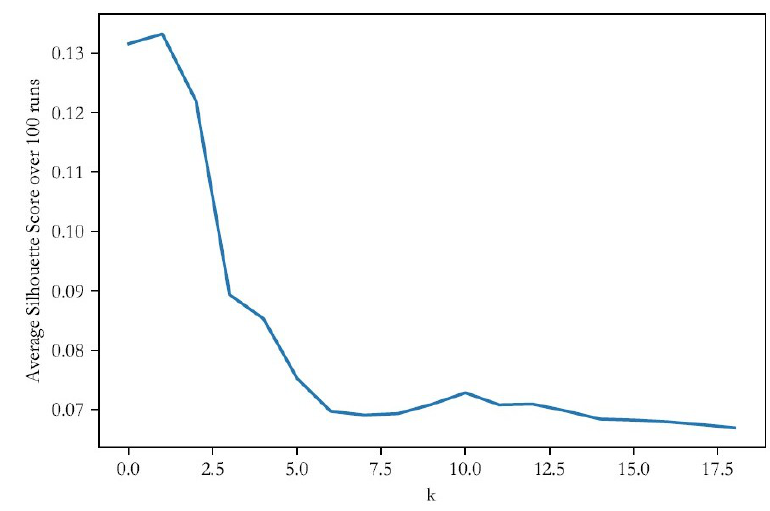
Figure 3. Average silhouette values for different values of k , rural block groups.